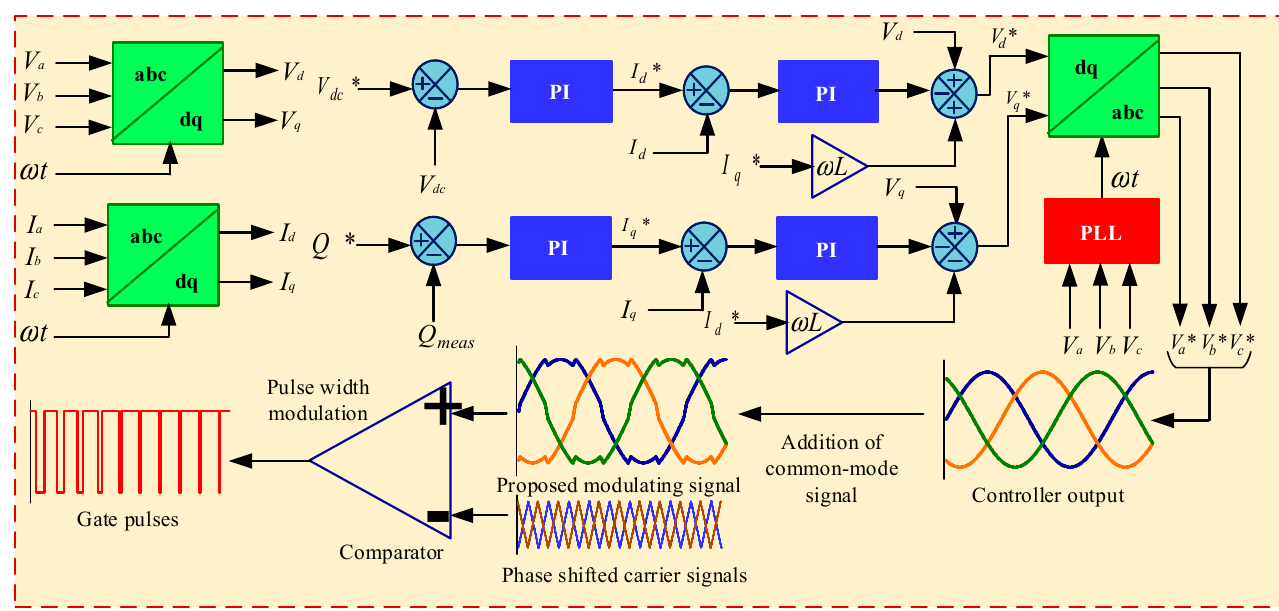
Figure 11. Control scheme for the MMC inverter-based grid-tied PV system with the implementation of the proposed TSCMPWM technique.